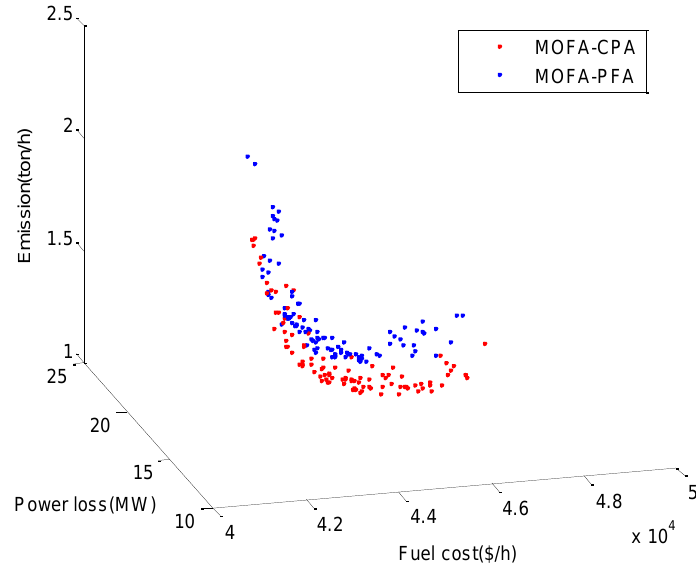
Figure 6. PFs obtained by MOFA-CPA and MOFA-PFA for Case 6. Table 8. Comparisons of the BCSs found by the MOFA-CPA and MOFA-PFA algorithms for Case 6.